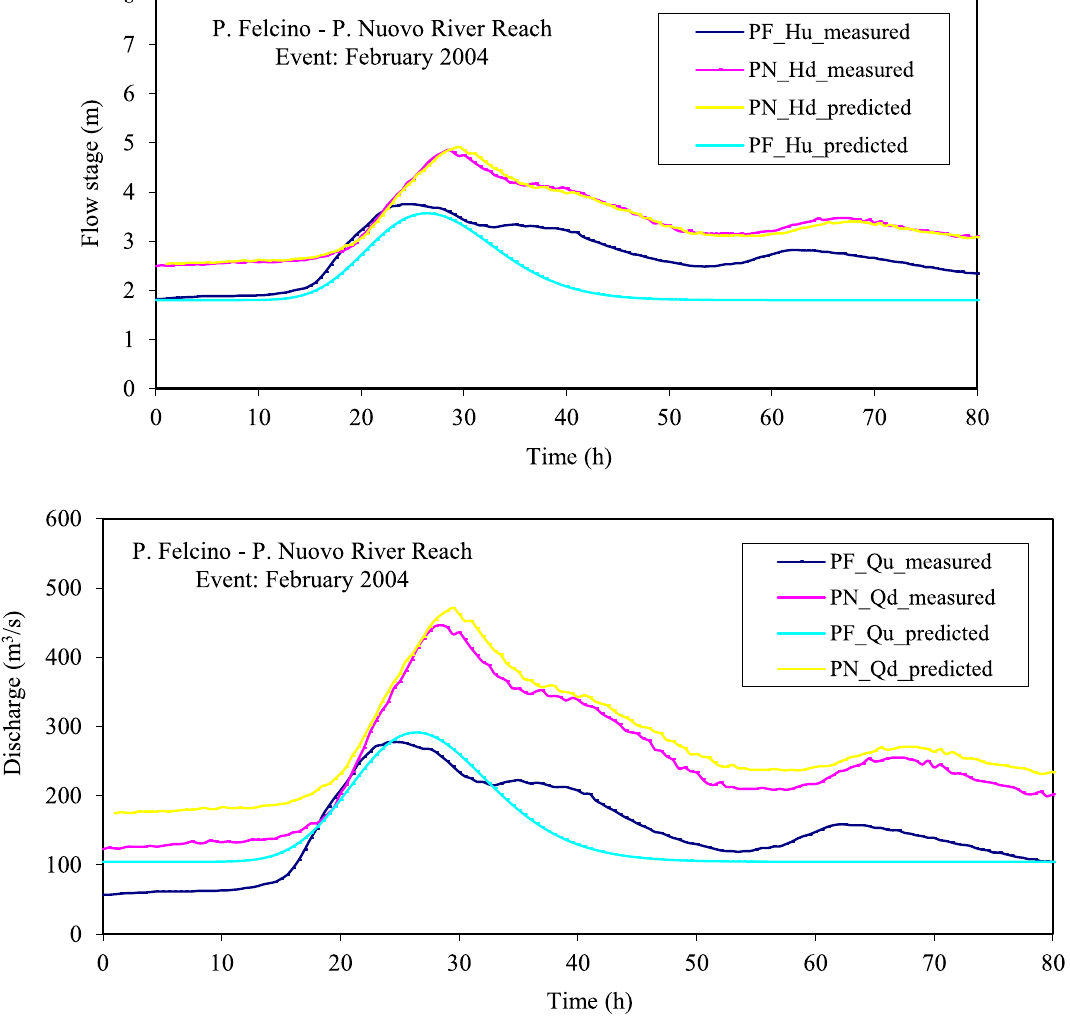
Fig. 7 Flow stage (above) and flow discharge (below) hydrograph simulations for event February 2004 in P. Felcino and P. Nuovo river